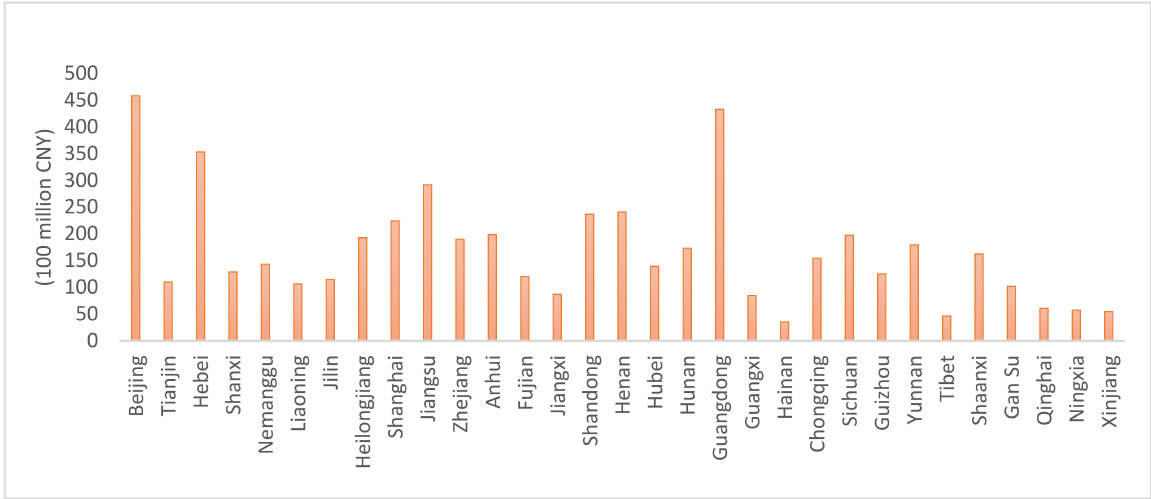
Figure 2. The local Chinese provincial fiscal expenditure on environmental protection (100 million CNY) in